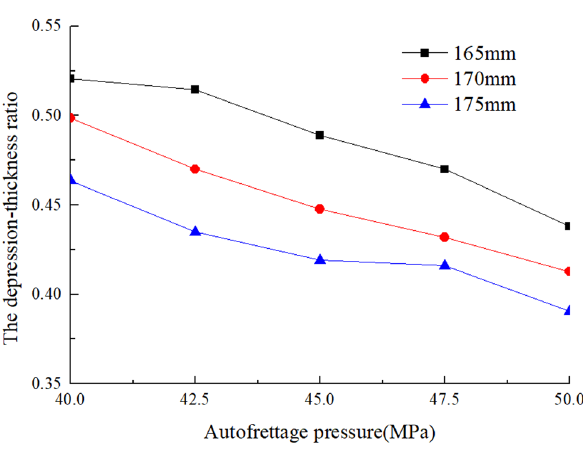
Figure 10: Relationship between the depression - thickness ratio and autofrettage pressure considering the variation of liner radius.